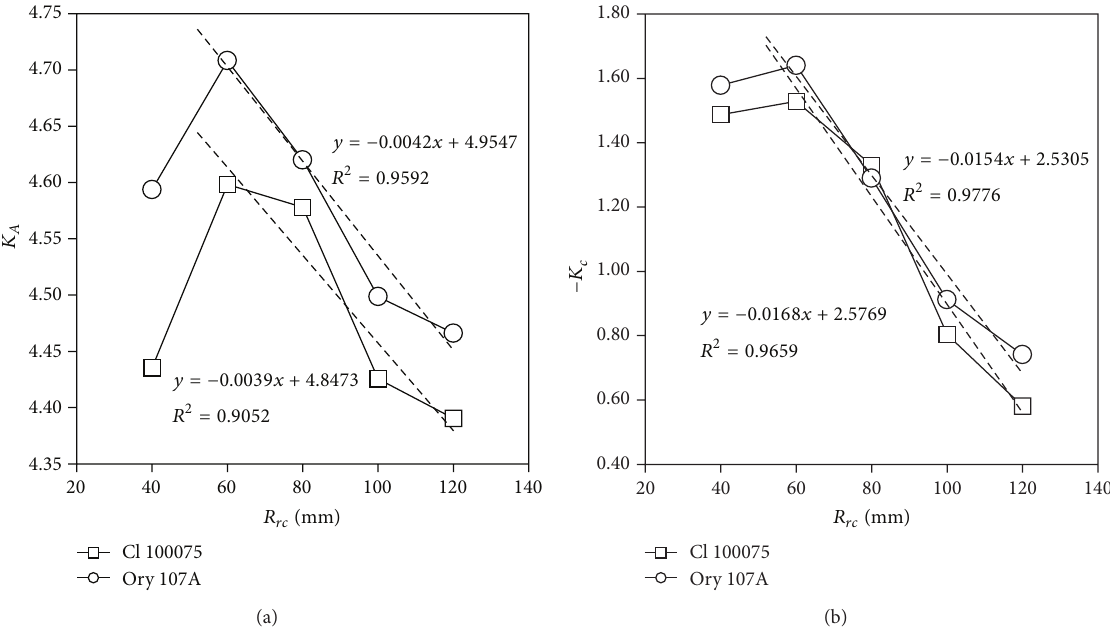
Figure 7: Coefficients 𝐾 𝐴 and 𝐾 𝑐 , plotted as a function of 𝑅 𝑟𝑐 , for both anemometers, Climatronics 100075 and Ornytion 107A. The linear fittings to the data have been included in the graphs for 𝑅 𝑟𝑐 ≥ 60 mm (in other words, they were calculated excluding the point 𝑅 𝑟𝑐 = 40